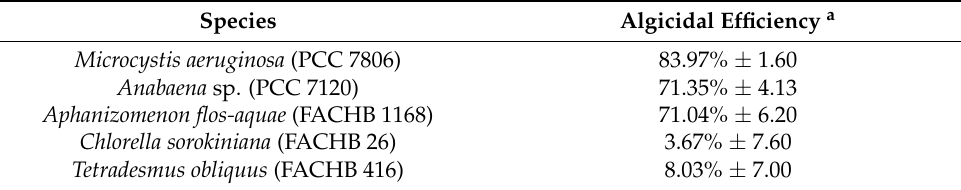
Table 1. The algicidal efficiency of Peanibacillus sp. SJ-73 on different algae species.